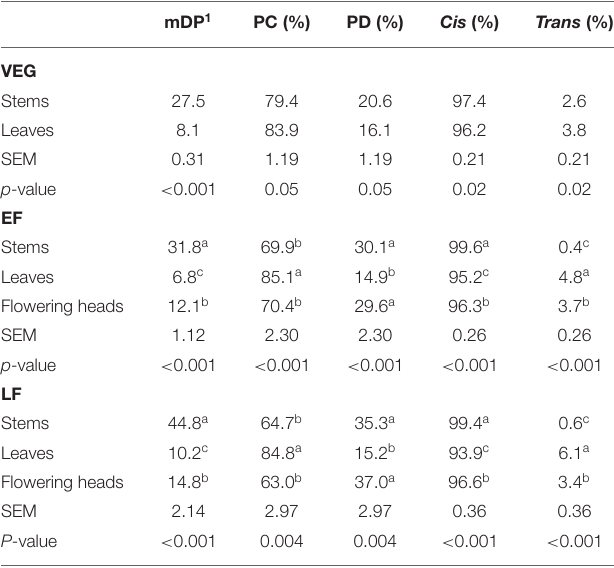
TABLE 3 | Composition of CT in stems, leaves, and flowering heads of PPC ( Dalea purpurea Vent) harvested at VEG, EF, or LF.